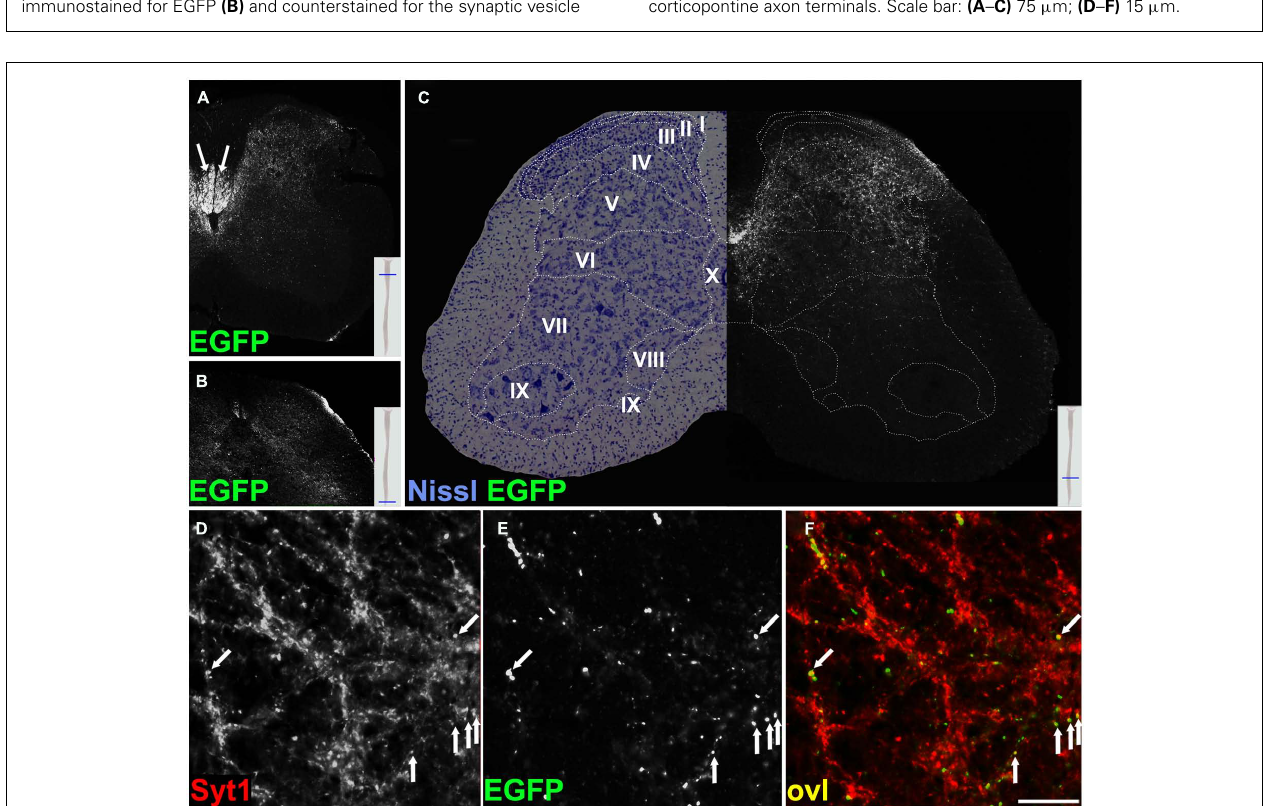
protein synaptotagmin1 (Syt1) (A) . Overlay in (C) . (D – F) are magnifications of the corresponding insets in (C) . Double-positive puncta (yellow, ovl) represent